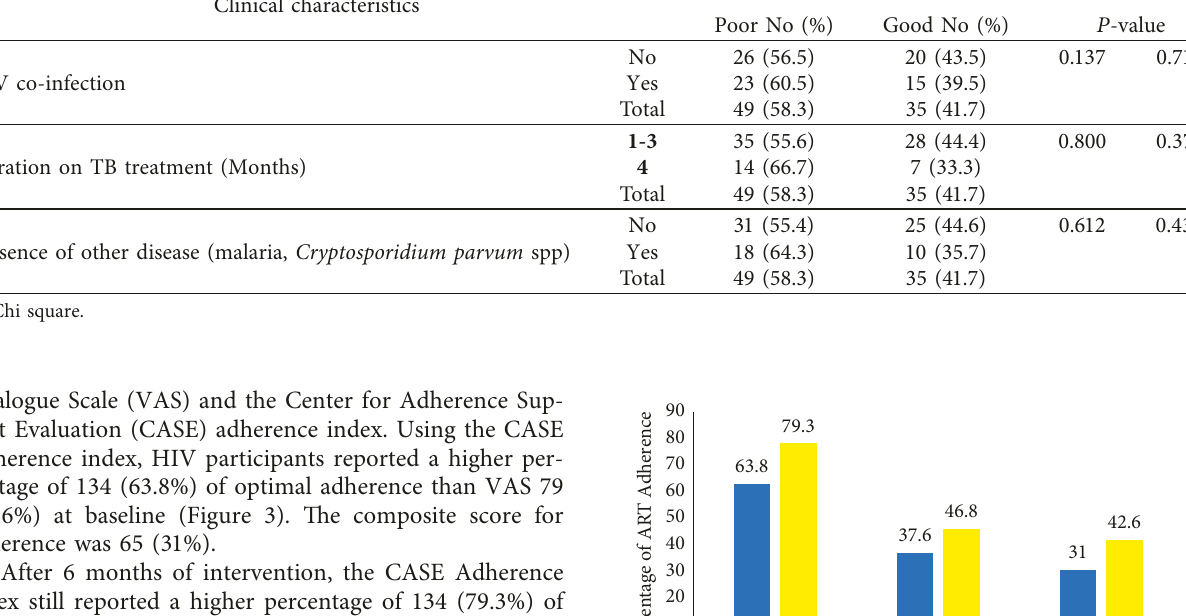
Table 6: Adherence to TB treatment and clinical characteristics among participants from the Buea and Kumba Hospitals. Clinical characteristics